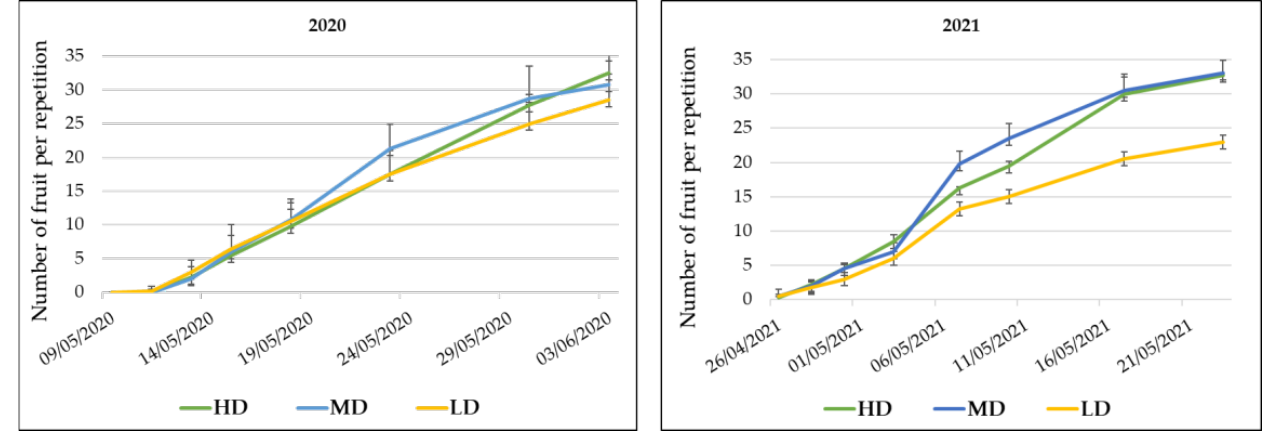
Figure 4. Cumulative production (diploid and triploid combined) as the number of fruit set through- out the watermelon cycle within the enclosures. Years 2020 (left) and 2021 (right) for the tree treatments (HD, MD, and LD release density). Table 4. Number of fruits per plant, fruit weight, and yield in the enclosures, for both watermelon cultivars. Years 2020 and 2021 for the three treatments (release density: HD, MD and